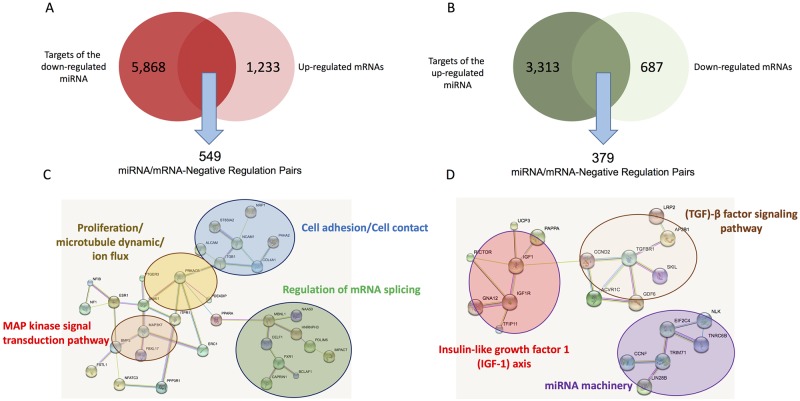
Inverse correlations between altered miRNAs and mRNA expressions in left atria from patients suffering from valvular heart disease with or without atrial fibrillation. Predictions are from TARGETSCAN.A) Data crossing between target gene predictions of the down-regulated miRNAs and the up-regulated mRNA from transcriptomic analyses. B) Data crossing between target gene predictions of the up-regulated miRNAs and the down-regulated mRNA from transcriptomic analyses. (C) and (D), the 100 most miRNA-targeted genes from the 2 lists (549 and 379) were analysed by using STRING to determine whether they were in included in protein-protein interaction networks.